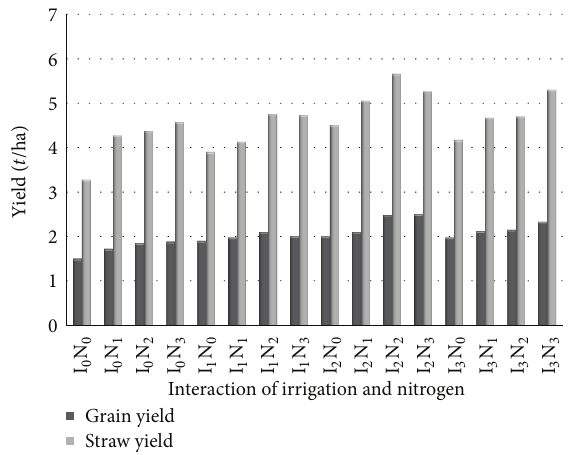
Figure 3: Combined effect of irrigation and nitrogen on the performance of